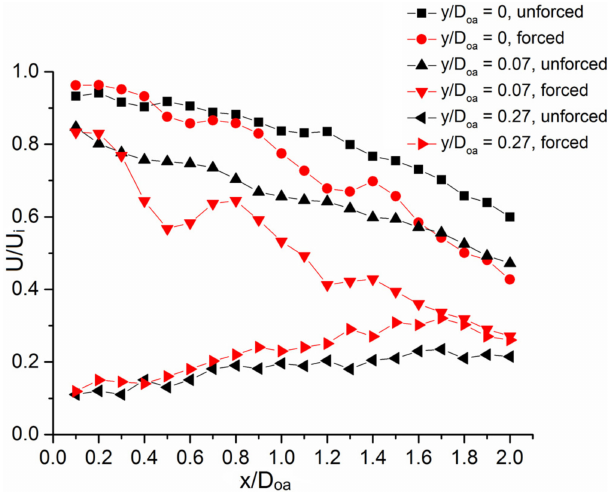
Figure 7. Velocity distribution along axial direction at different sections of nozzle